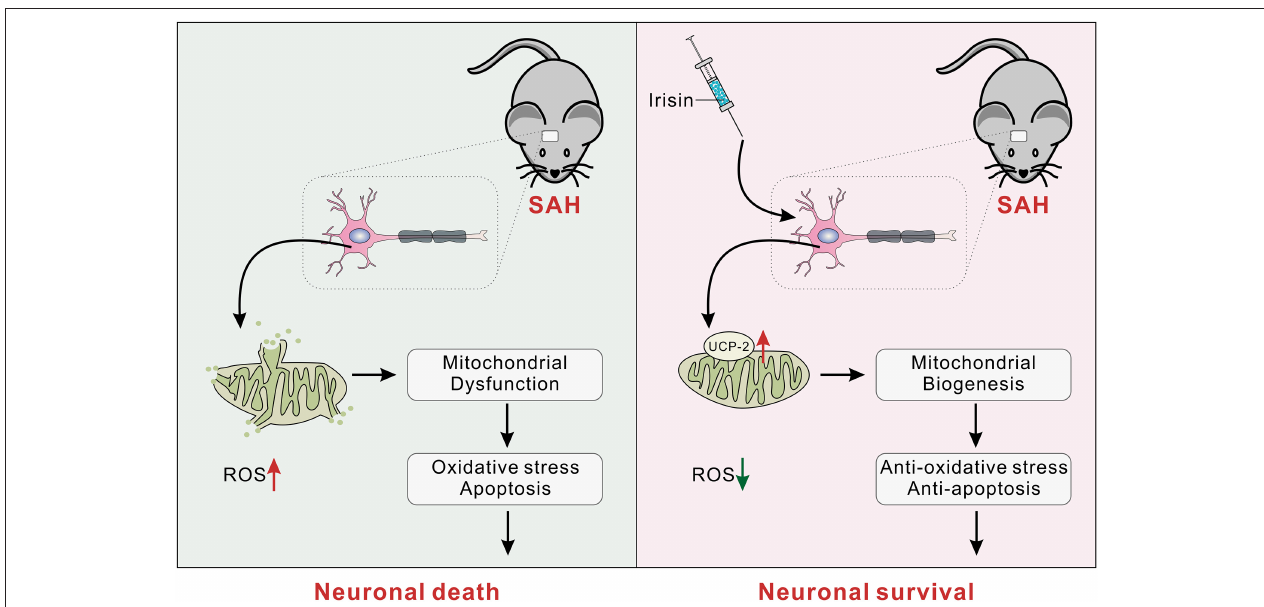
FIGURE 9 | The schematic of irisin on mitochondrial biogenesis following SAH. SAH, subarachnoid